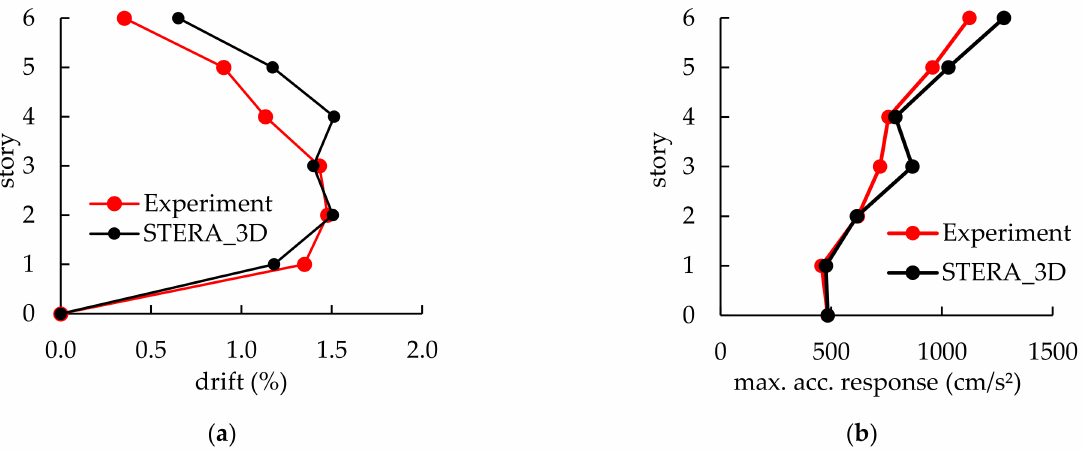
Figure 11. Comparison of experiment of stepped setback structure specimen with STERA_3D response: ( a ) interstory drift; ( b ) maximum acceleration.